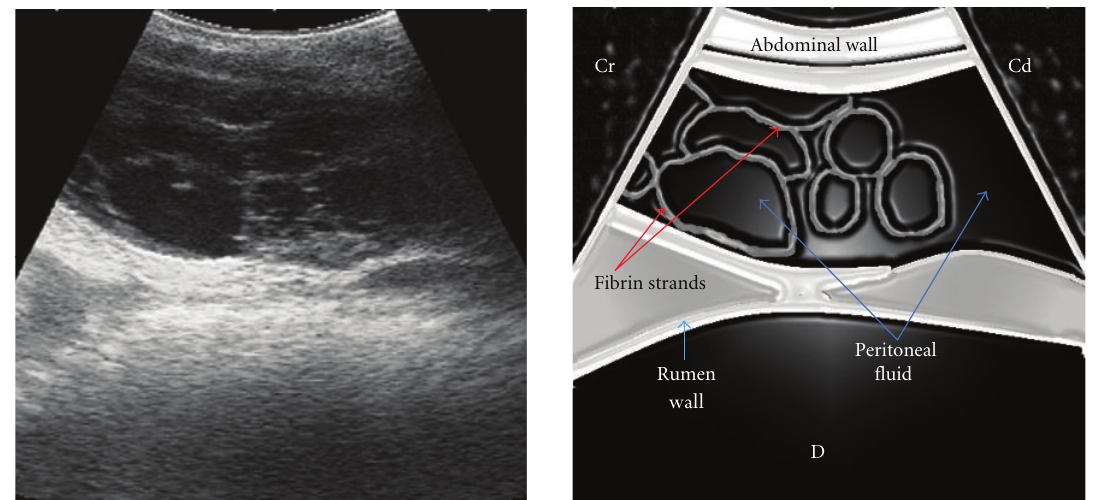
Figure 14: Left paramedian sonogram depicting the deposition of the echogenic fibrin along with hypoechogenic fluid between the ventral abdominal wall and rumen. Cr: cranial; Cd: caudal; D: